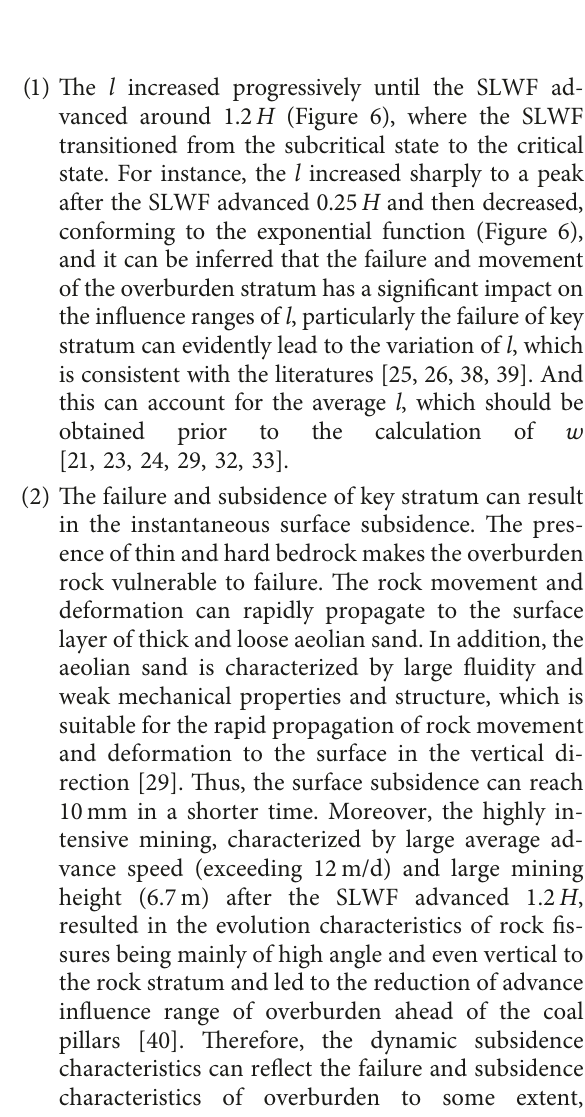
Figure 6: Dynamic curves of advance influence